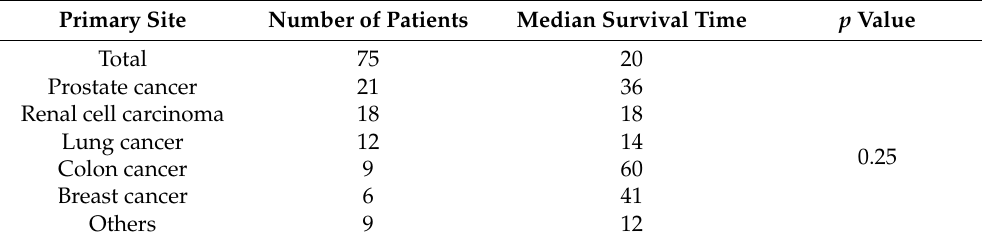
Table 1. Primary site and median survival times in patients with spinal